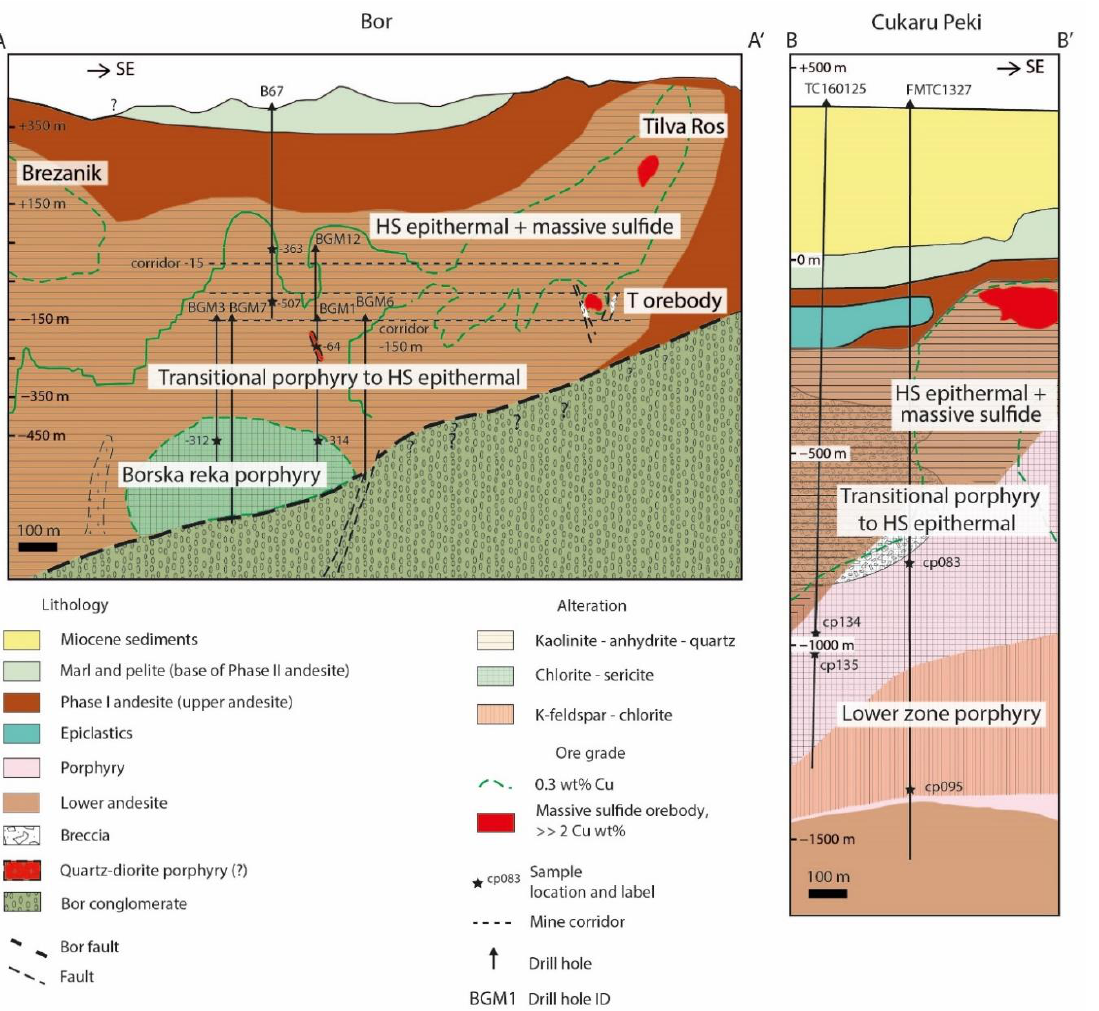
Figure 2. Cross-sections of Bor and Cukaru Peki deposits and locations of samples for U-Pb geo- chronology [1,2,10], with additions based on Bor and Cukaru Peki geologic